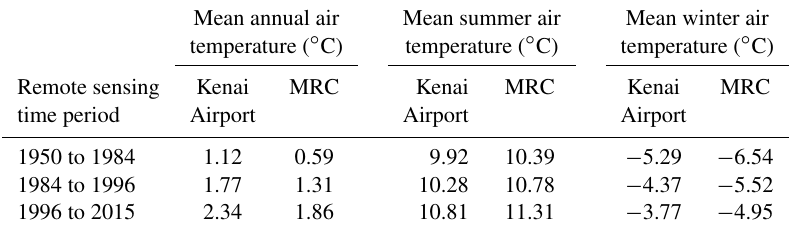
Table 4. Mean annual, mean summer (May to September), and mean winter (October to April) air temperature for the three remotely sensed image observation periods compiled from the Kenai Municipal Airport (WBAN 26523) and estimated from the MRC station (Kenai 29 ENE-AWS